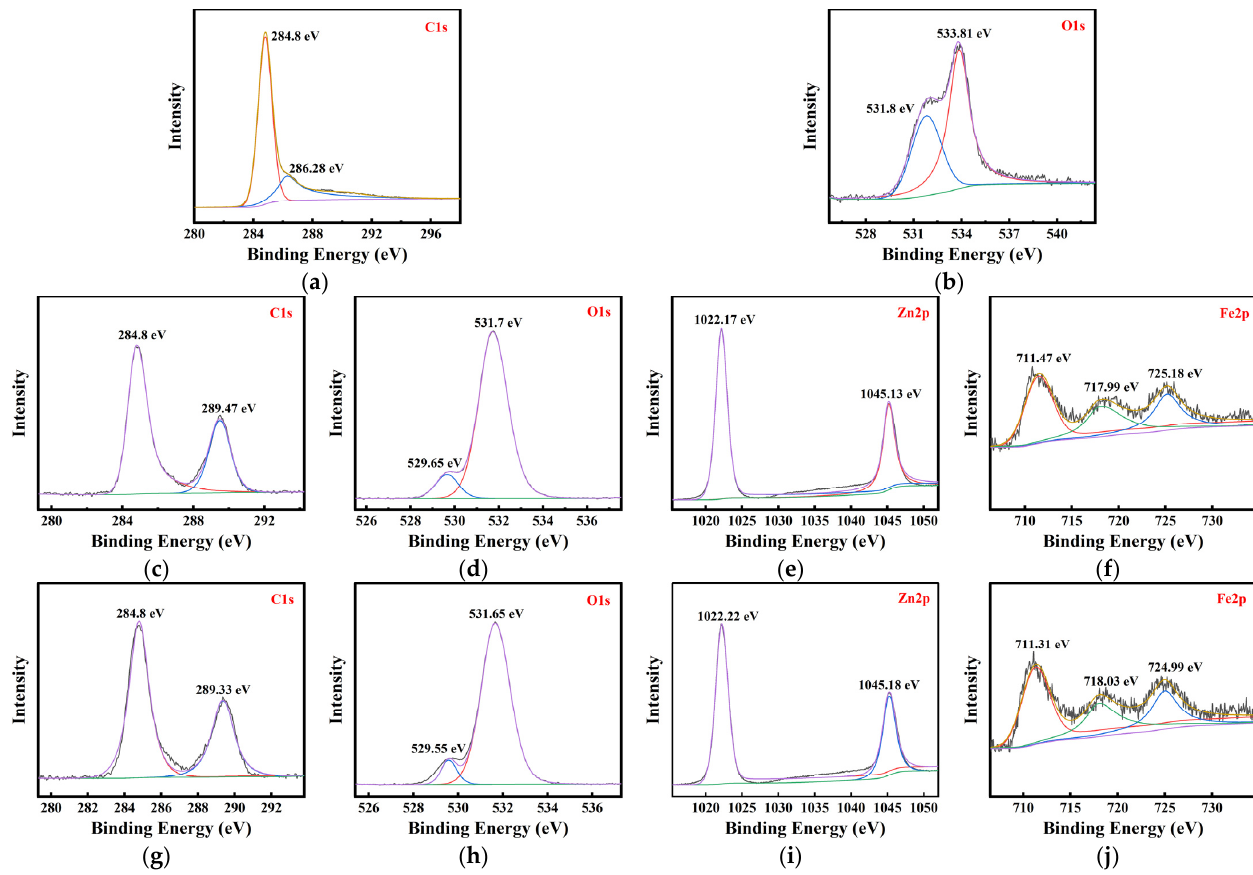
Figure 3. XPS fine spectra of ZnFe-LDH, FS/ZnFe-LDH, and FS. ( a , b ) FS; ( c – f ) ZnFe-LDH; ( g – j ) FS/ZnFe-LDH.